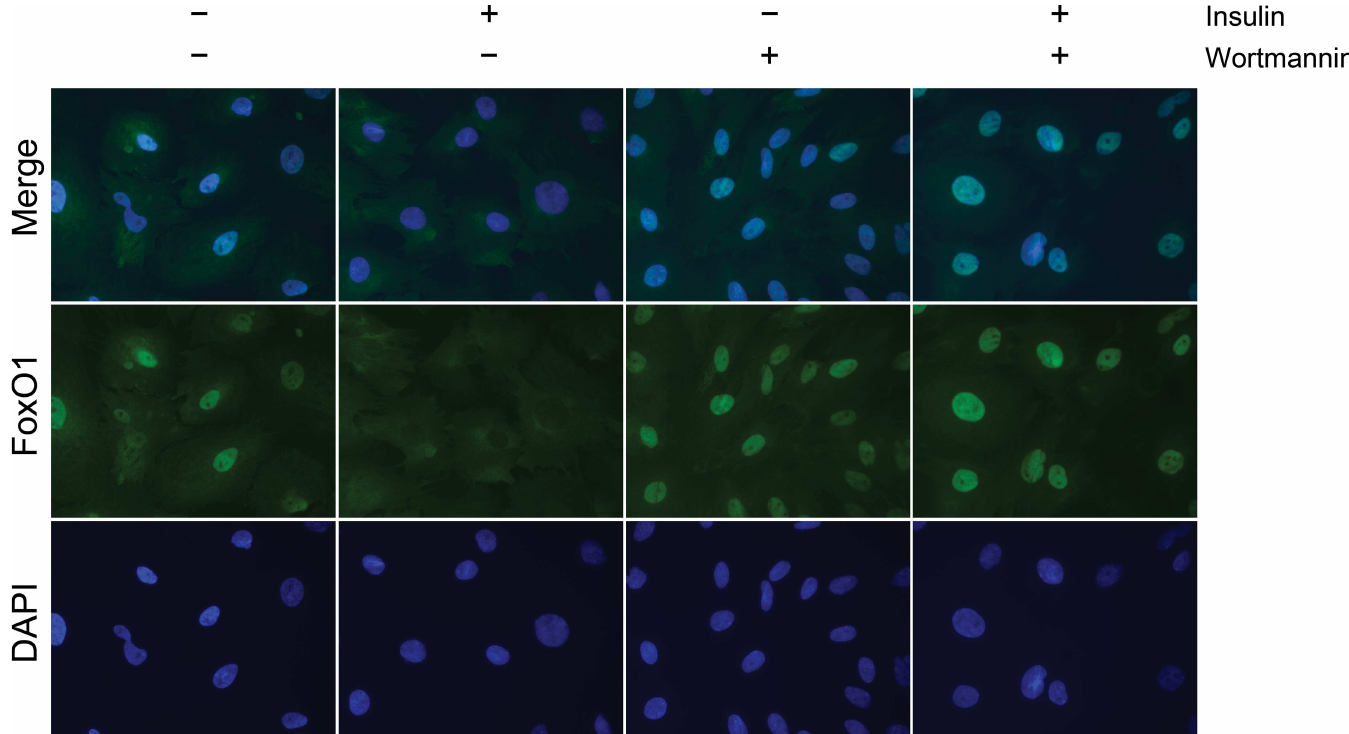
Fig 4. FOXO1 immunostaining in response to insulin and/or PI3K inhibitor. Representative fluorescent micrographs for FOXO1 (green) and DAPI- stained nucleus(blue) in decidualizedcells with 630x magnification. FOXO1 is located predominantly in the nucleusin the absenceof insulin,while exported from the nucleusin the presenceof insulin.Wortmannin, a PI3K inhibitorhas no effect on the subcellular localizationof FOXO1 alone,while in combination with insulinit blocks insulininducednuclearexport of FOXO1 .